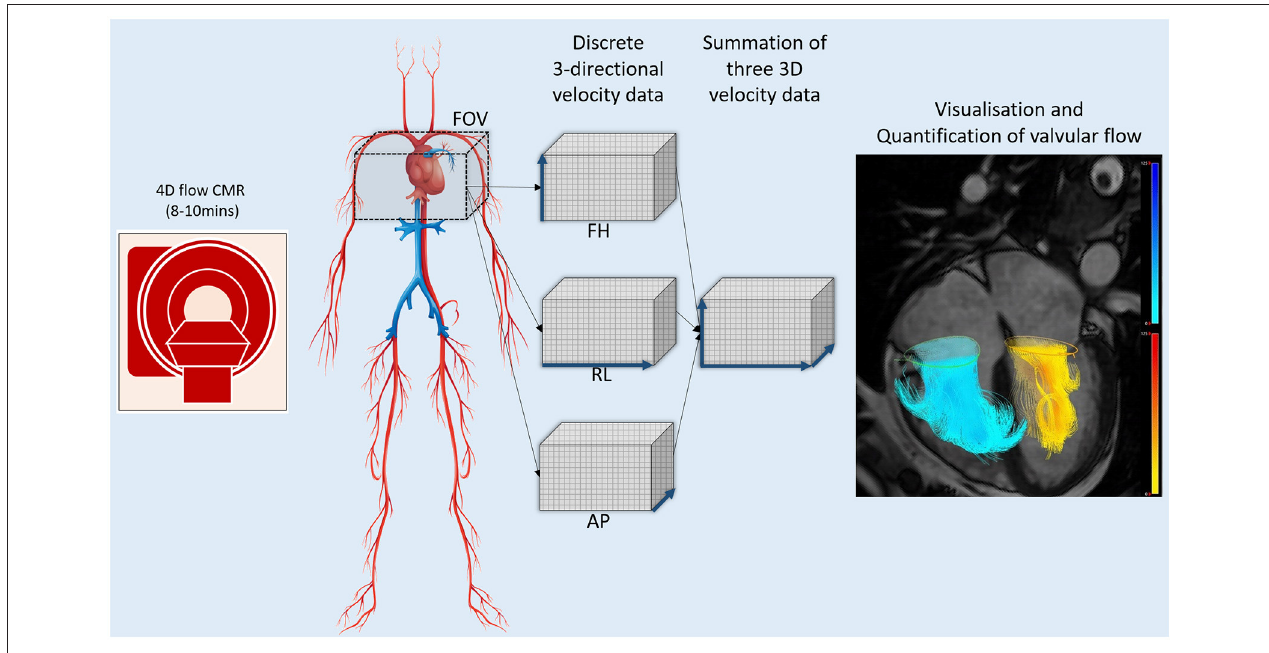
FIGURE 6 | Four-dimensional flow CMR